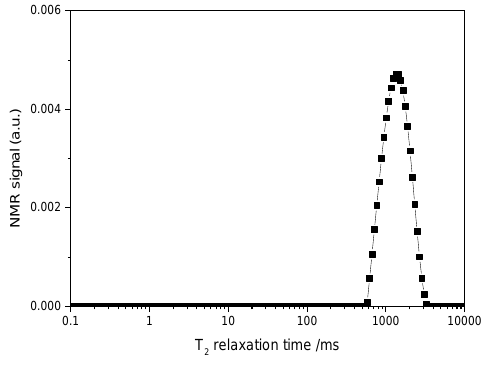
Figure 3. T 2 relaxation time of pure water.